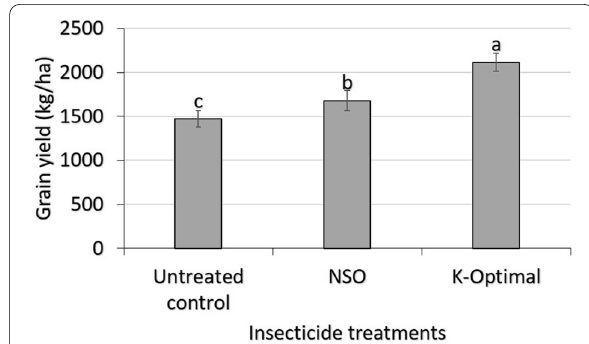
Fig. 5 Effect of insecticide treatments on grain yield of sorghum (kg/ ha) in the 2017 cropping season. Data are means standard error of ± means (S.E.M.). NSO Neem seed oil; Bars with different letters are = significantly different at 5% probability threshold